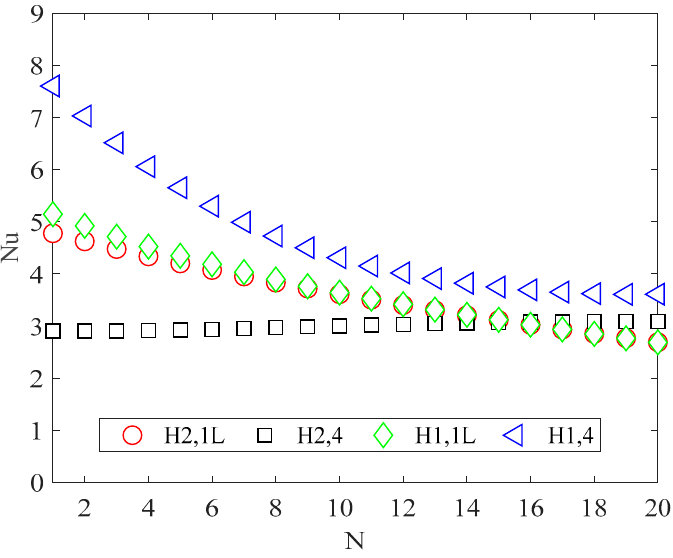
Figure 7. Nusselt number for different channel numbers and conditions.